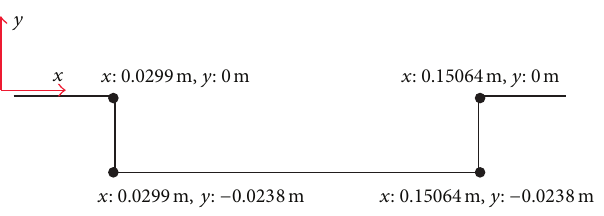
Figure 2: Cavity configuration with coordinates.